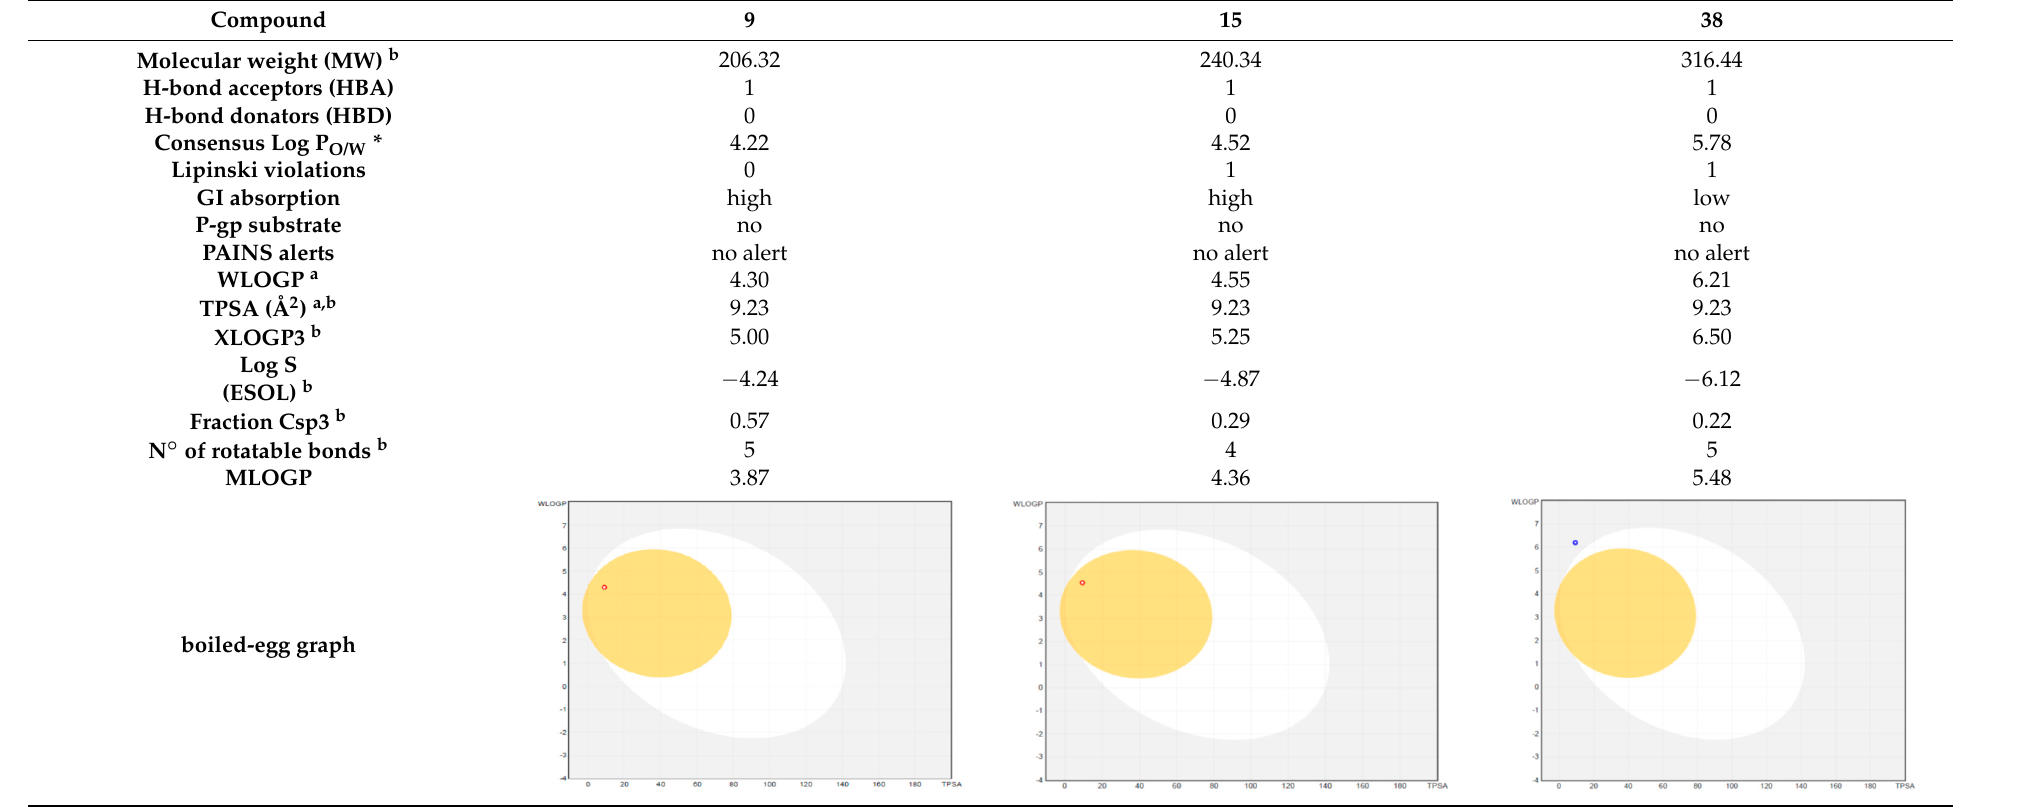
Table 3. In silico evaluated physicochemical properties of the top-rated compounds 9 , 15 , and 38 .